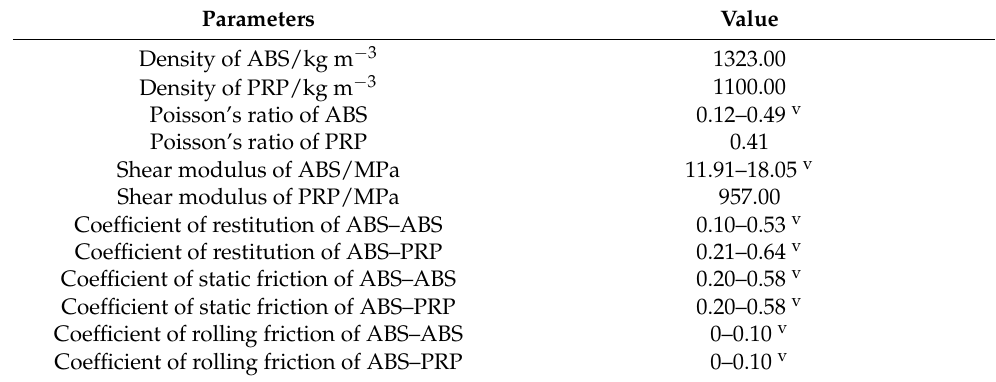
Table 1. Simulation parameters.